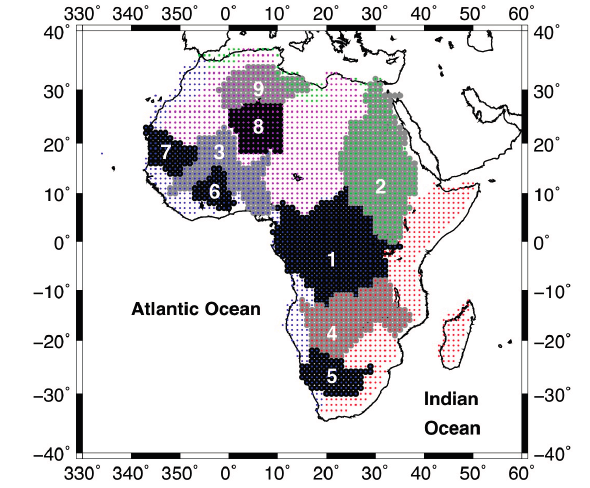
Figure 1. Geographical locations of the main drainage basins of Africa used in this study: (1) Congo (~4 million square kilometers); (2) Nile (~3.4 million km 2 ); (3) Niger (~2.1 million km 2 ); (4) Zambezi (~1.4 million km 2 ); (5) Orange (~0.97 million km 2 ); (6) Volta (~408,000 km 2 ); (7) Senegal (~270,000 km 2 ); as well as the areas contributing to the Atlantic Ocean (blue dots), India Ocean (red dots), Mediterranean Sea (green dots) and the endorheic ensemble (purple dots). The driest part of the Sahara Desert area in South Algeria (8) (~1.1 million km 2 ) and (9) the North Western Sahara Aquifer System (NWSAS) (~1.6 million km 2 ) are also